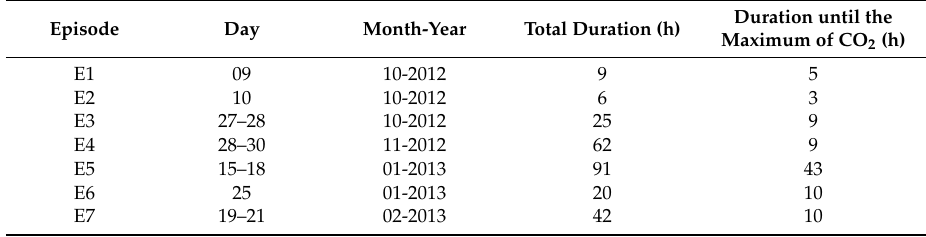
Figure 2. Temporal variation of the mixing ratios of CO 2 , CO, and CH 4 , as well as the stable carbon isotope ratio of atmospheric CO 2 ( δ 13 C), for five months at the Environmental Research Station Schneefernerhaus (UFS). The arrows point to the studied episodes labeled E1–E7. The shaded areas indicate distinct pollution events (the first event actually contains separate two events, but due to the short period between them the shaded area is shown as a single event). Table 2. Date and duration of investigated episodes.